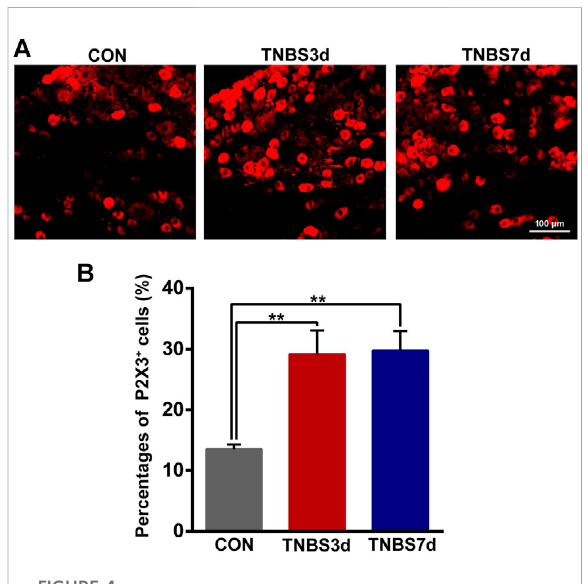
FIGURE 4 TNBS-induced colitis increased P2X3 expression in the neurons of L6-S1 DRG. (A) Immuno fl uorescence labeling of the P2X3 receptor in L6-S1 DRG showed that TNBS-induced colitis increased P2X3 expression on the small- and middle-sized neurons. (B) Histogram showed that the percentage of P2X3-